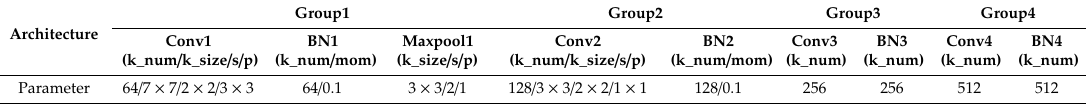
Figure 5. Spatial Feature Transformer Architecture. Conv and pool represent the convolutional and pooling layers. Bn is the batch normalization layer. Table 1. Spatial Feature Transformer (SFT) Architecture Parameter Setting.